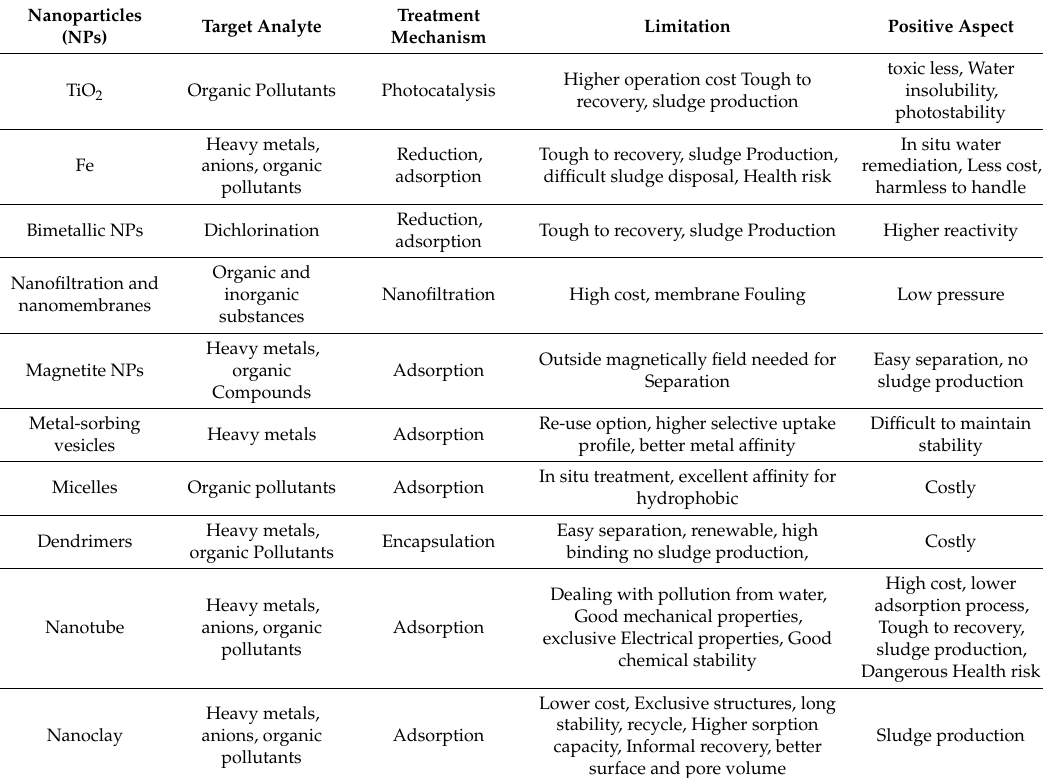
Table 7. Summary of water treatments by using nanomaterial by di ff erent mechanisms